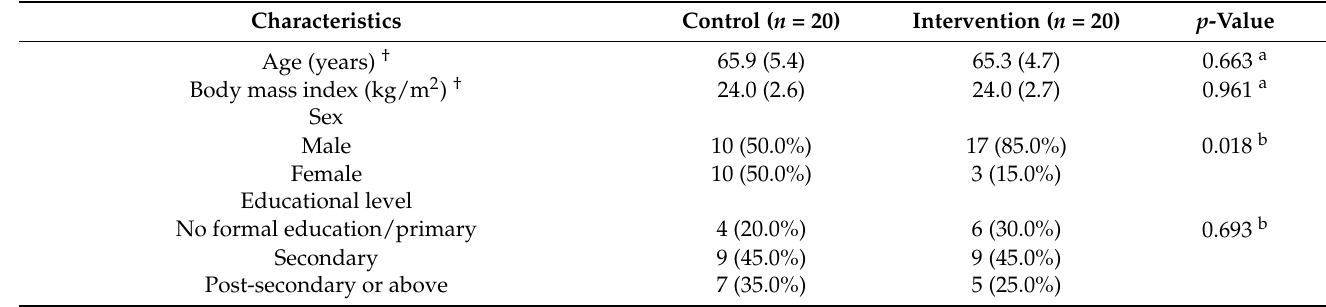
Table 2. Characteristics of the study participants ( n = 40).